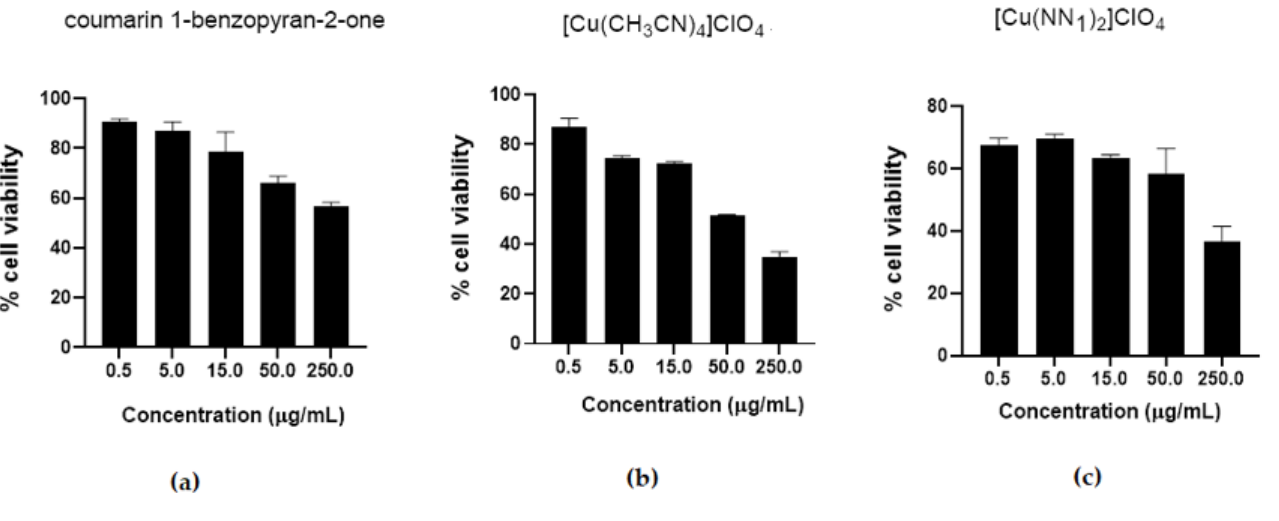
Figure 2. Determination of cytotoxicity of test compounds on CHSE-214 cells. CHSE-214 cells were treated with 0.5, 15.0, 50.0 and 250.0 µ g/mL of ( a ) coumarin, ( b ) ([Cu(CH 3 CN) 4 ]ClO 4 ) and ( c ) copper(I) complex [Cu(NN 1 ) 2 ]ClO 4 and viability was determined by flow cytometry.